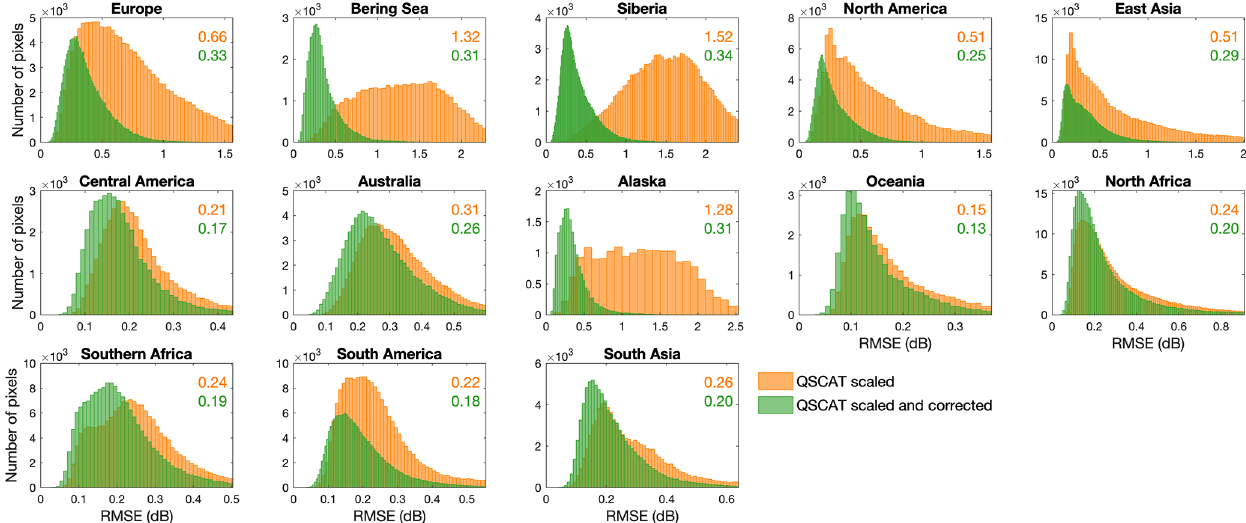
Figure 7. RMSE-based quality assessment of the LHScat data set at the pixel level. Each panel shows the result of one region. Inside each panel, the RMSE values (dB) between the C-band and the scaled Ku-band signals in the overlapping years (1999–2001 and 2007–2009) were calculated for all pixels and coloured in orange. As a comparison, the RMSE values between the C-band and the corrected Ku-band signals in the overlapping years were also calculated and coloured in green. The medians of the RMSE values are labelled inside each panel. The rRMSE-based quality assessment is available in the Supplement (Figs. S2 and